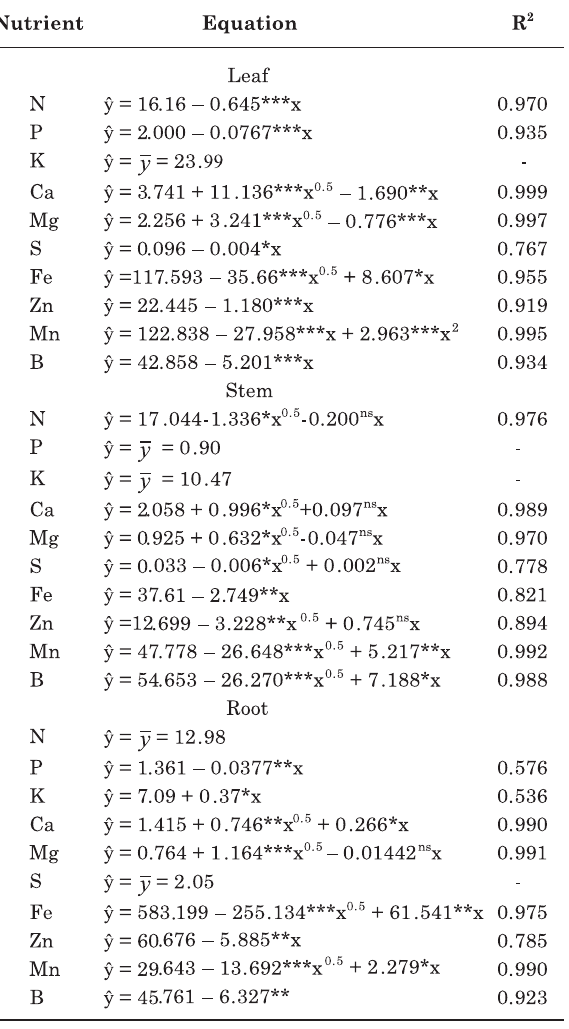
Table 2. Regression equations adjusted for concentrations of macro (g kg -1 ) and micronutrients (mg kg -1 ) in leaves, stems and roots of Epidendrum ibaguense as a variable of lime rates (g dm -3 ) applied to the growth